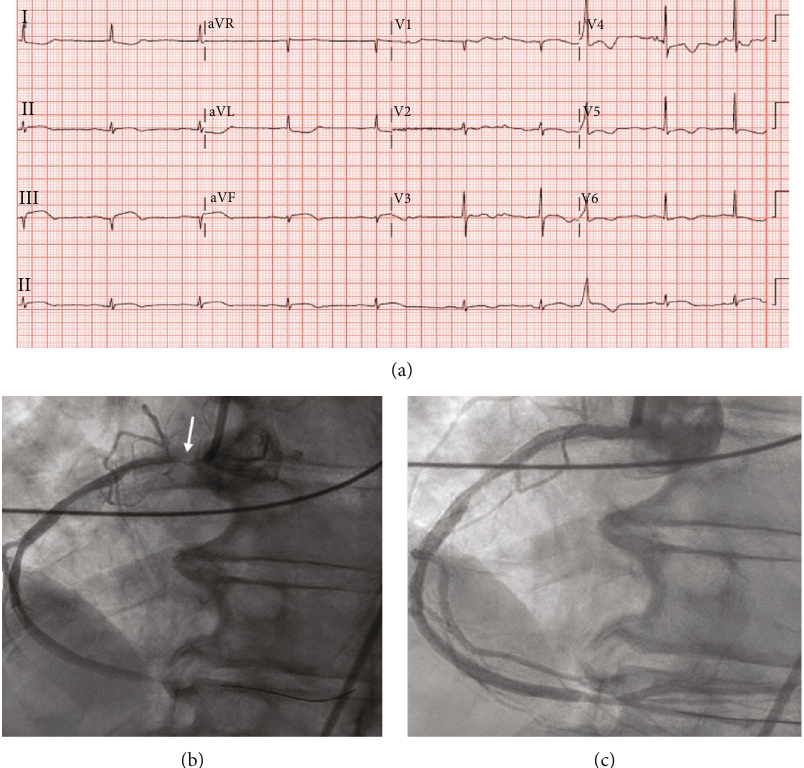
Figure 3: ECG on admission and LHC fi ndings. (a) ECG showing ST elevations in inferolateral leads. (b) Initial coronary angiography with arrow showing RCA ostium. (c) Coronary angiography after